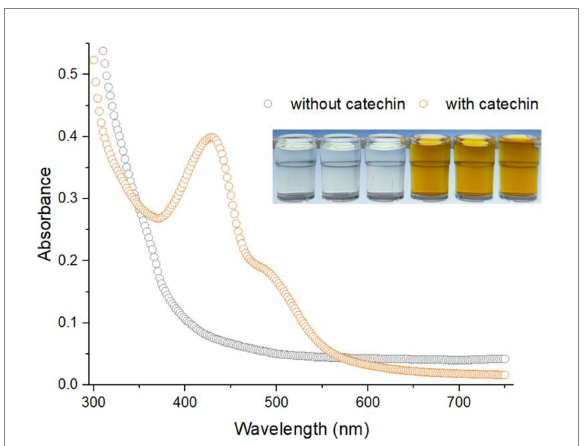
FIGURE 2 The visible absorption spectrum of water-soluble CACD generated from Pb(II)-induced TOP10/pPb-CACD. The inset shows the cell-free culture supernatants of 50 mM Pb(II)- induced TOP10/pPb-CACD supplemented with or without 1 mM catechin. The maximum absorption peak of secreted CACD is located at around 428 nm. Data are representative of three independent tests with similar